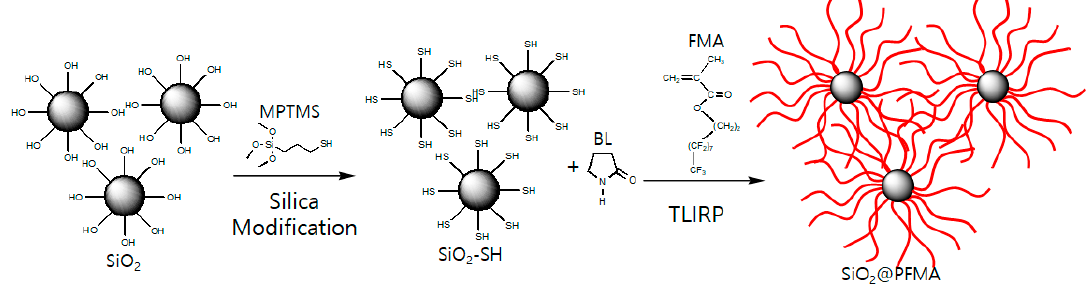
Scheme 1. Synthesis of SiO 2 -SH and polymerization of FMA “ grafting from ” the SiO 2